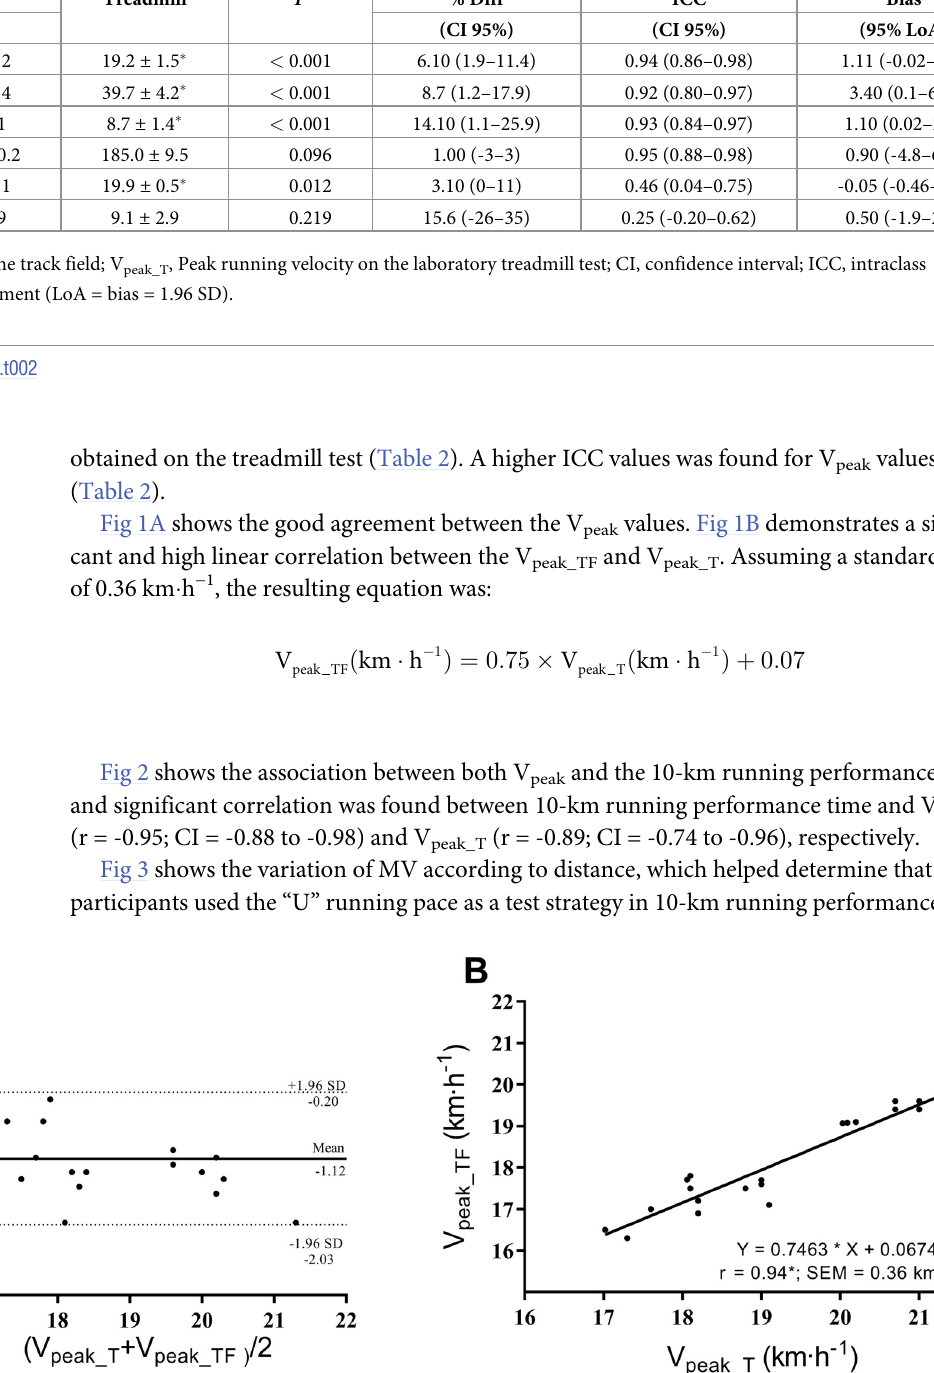
Table 2. Comparison, association and agreement between variables obtained during the track field and treadmill tests (N = 20).